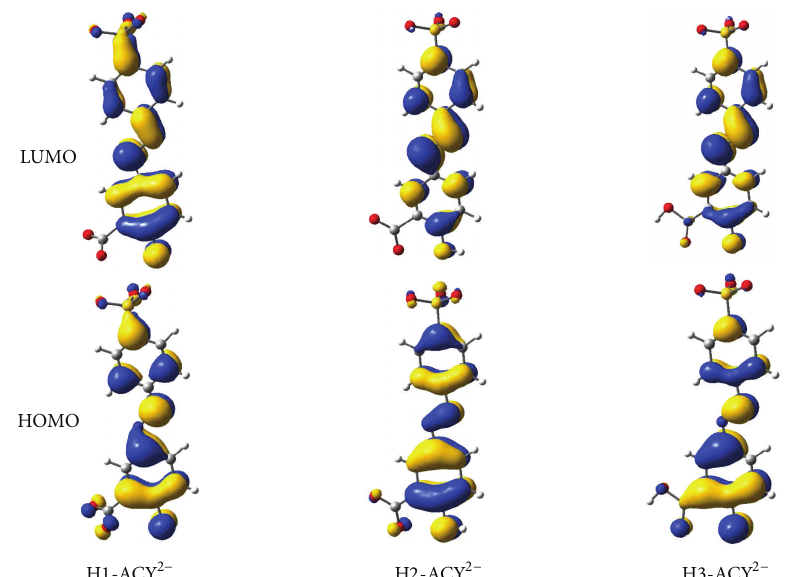
Figure 3: Isodensity surfaces (0.03e/bohr 3 ) of the key molecular orbitals of the double deprotonated forms of the dye calculated at DFT/B3LYP/6-31+G(d) level in